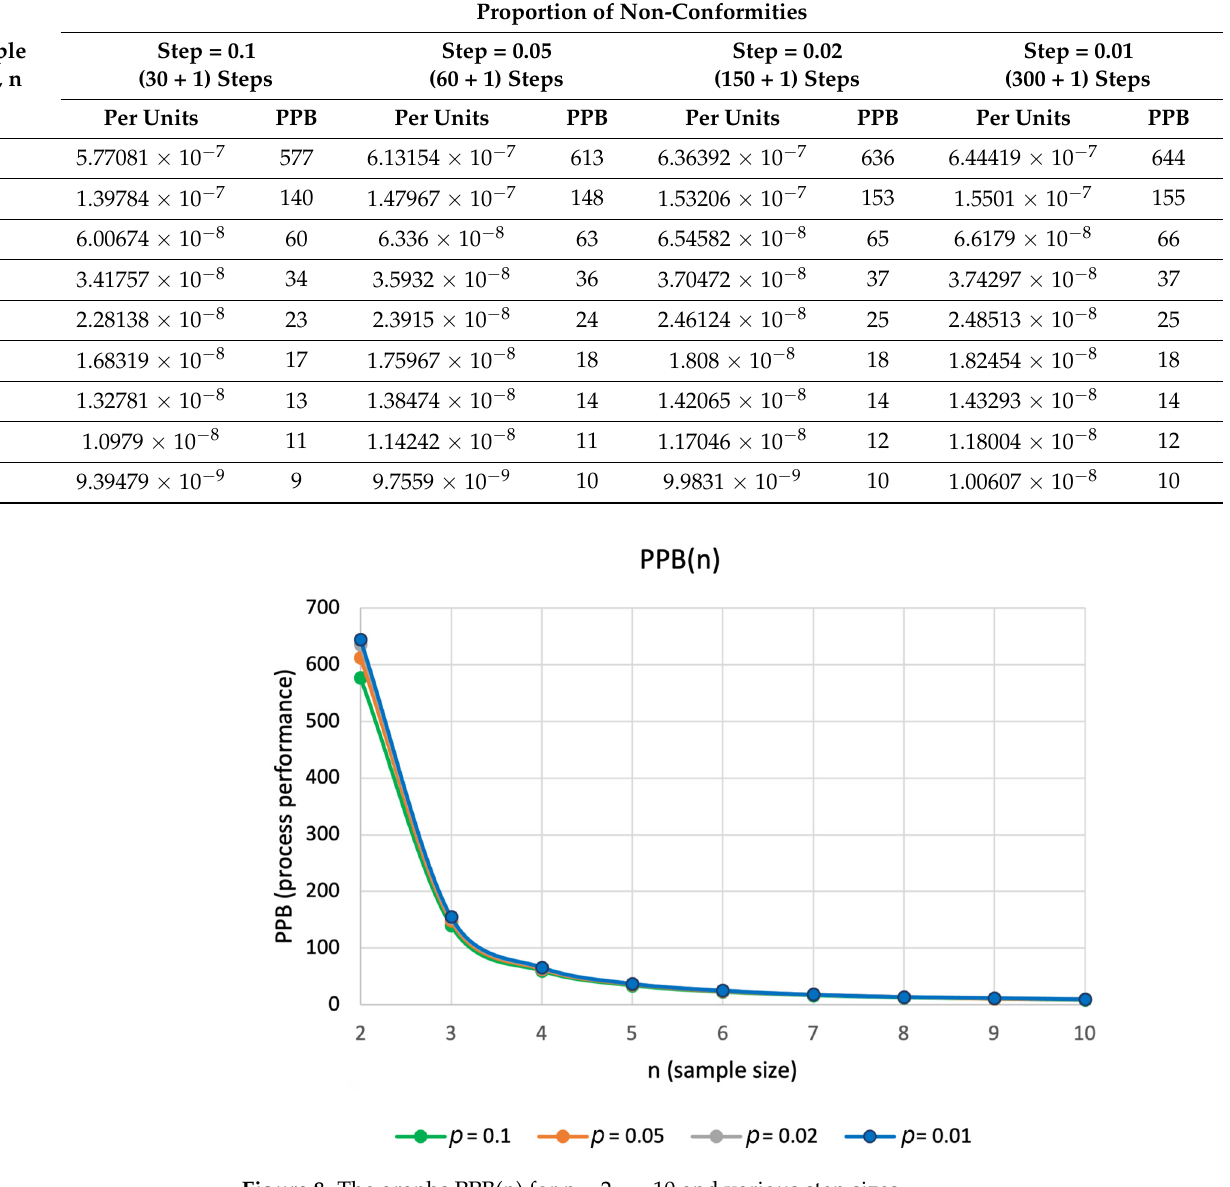
Figure 9. The graph PPB(n) for n = 2…10 and for step size p = 0.01.